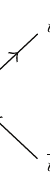
Figure 9: Feynman diagram illustrating resonant production and decay of ̃ ] 𝜏 . 𝑙 𝑖 and 𝑙 𝑗 can be 𝑒 , 𝜇 , or 𝜏 , where 𝑖 ̸= 𝑗 . The blue dots indicate RPV couplings 𝜆 󸀠 311 and 𝜆 𝑖 3 𝑗 ( 𝑖 ̸= 𝑗 ), respectively (from